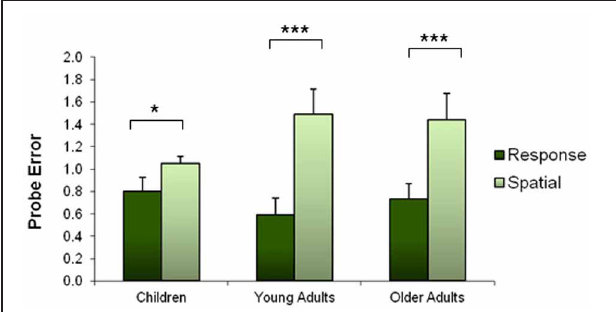
FIGURE 4 | Normalized mean number of probe errors according to strategy and age group. This graph shows that probe errors were effective at dissociating spatial and response strategies: spatial learners made more errors on the probe trial than response learners. Error bars represent standard error of the mean. ∗ p < 0 . 05; ∗∗∗ p < 0 .